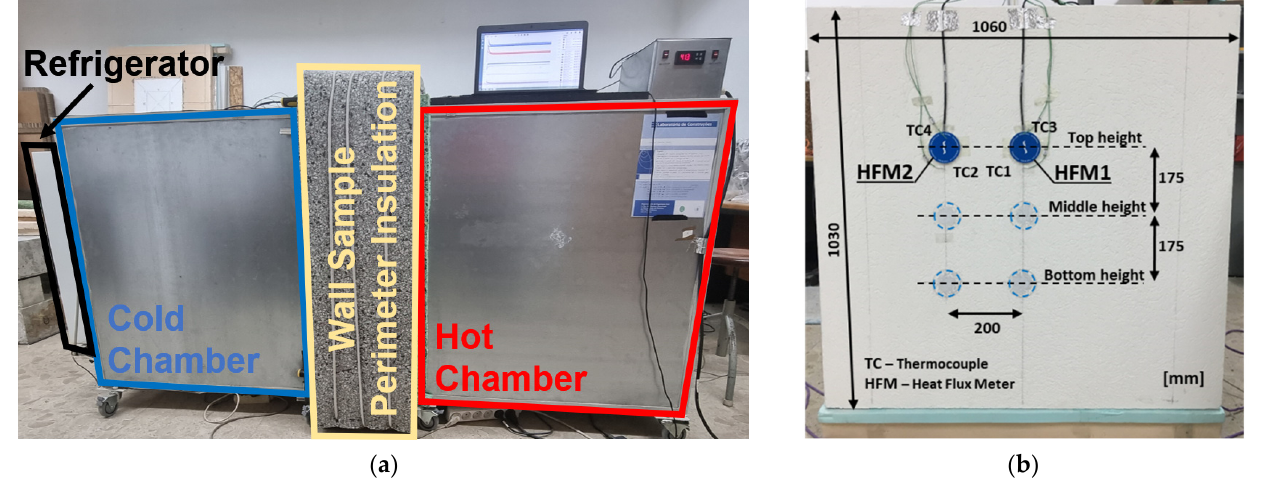
Figure 4. Experimental apparatus for the 𝑅 -value lab measurements. ( a ) Thermal chambers. ( b ) Sensors on the cold surface.